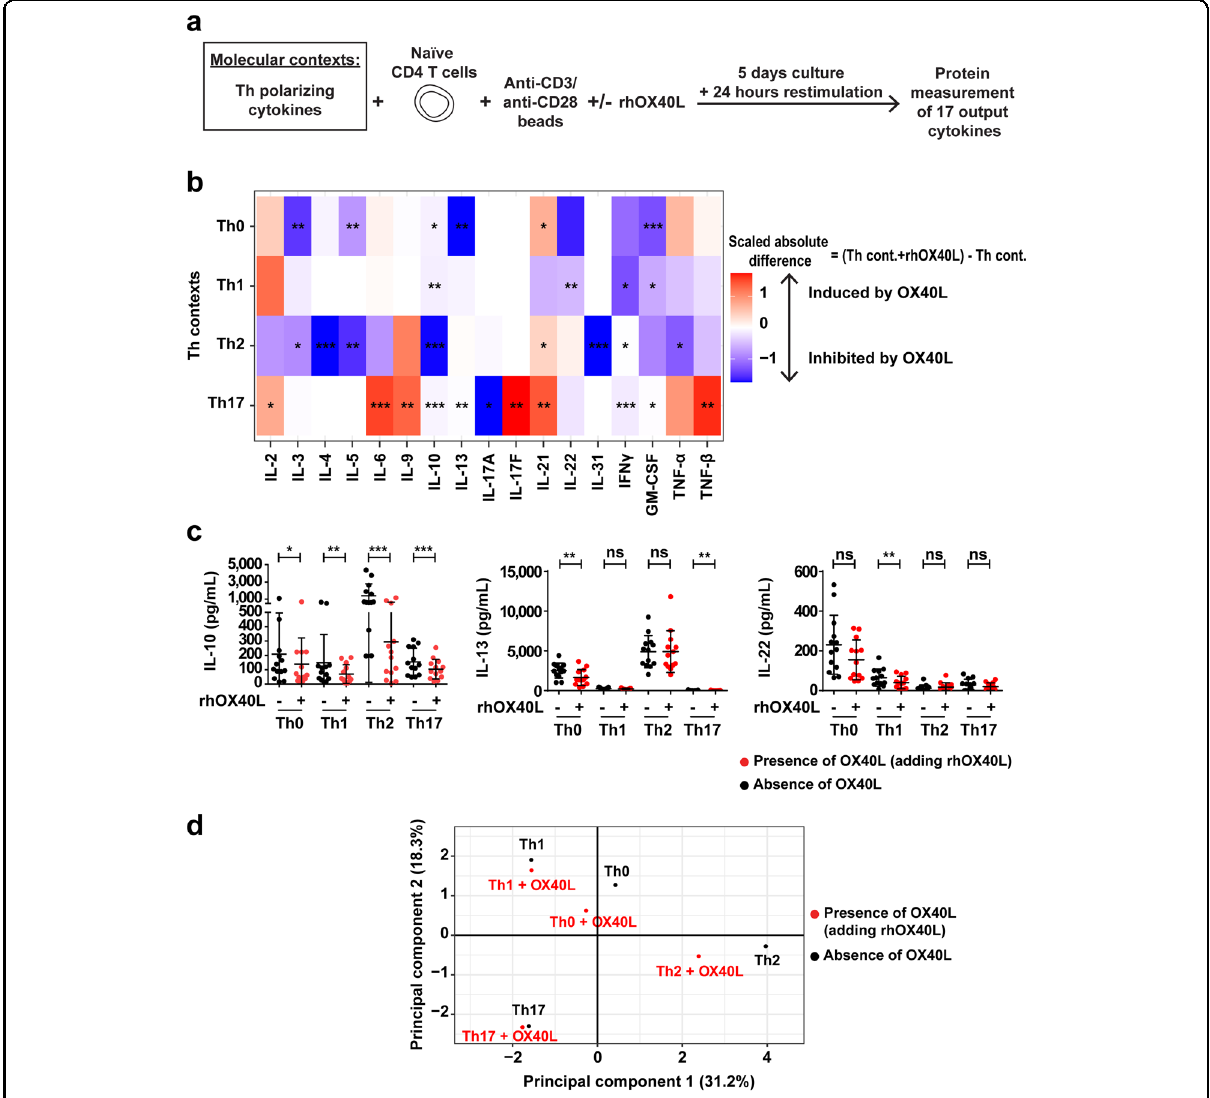
Fig. 1 The impact of OX40L on Th cell polarization depends on the cytokine polarizing context. a Experimental design of the Th cell polarization assay. b Heatmap representing OX40L-induced scaled absolute difference on the 17 output cytokines measured in each Th context. The absolute difference corresponds to the concentration of a given cytokine in a Th context in the presence minus absence of rhOX40L. The mean over 13 donors is represented. Paired Wilcoxon ’ s test was used to evaluate the signi fi cance of OX40L ’ s effect. c IL-10, IL-13, and IL-22 production in each Th context in the presence (red dots) or absence (black dots) of rhOX40L. Data are the means ± SD, and individual values from 13 donors are represented. Paired Wilcoxon ’ s test was used for statistical analysis. d PCA representing the barycenters of the four Th-polarizing contexts in the presence (red dots) or absence (black dots) of rhOX40L. ns, no signi fi cance; * P ≤ 0.05; ** P ≤ 0.01; *** P ≤